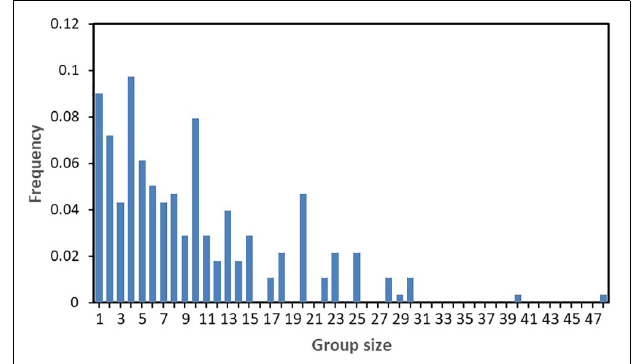
FIGURE 3 | Frequency histogram of 229 group size estimates of Indo-Pacific humpback dolphins in the eastern waters of Zhanjiang,